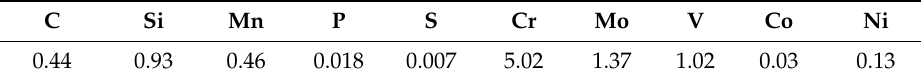
Table 1. The chemical composition of H13 steel (wt.%).